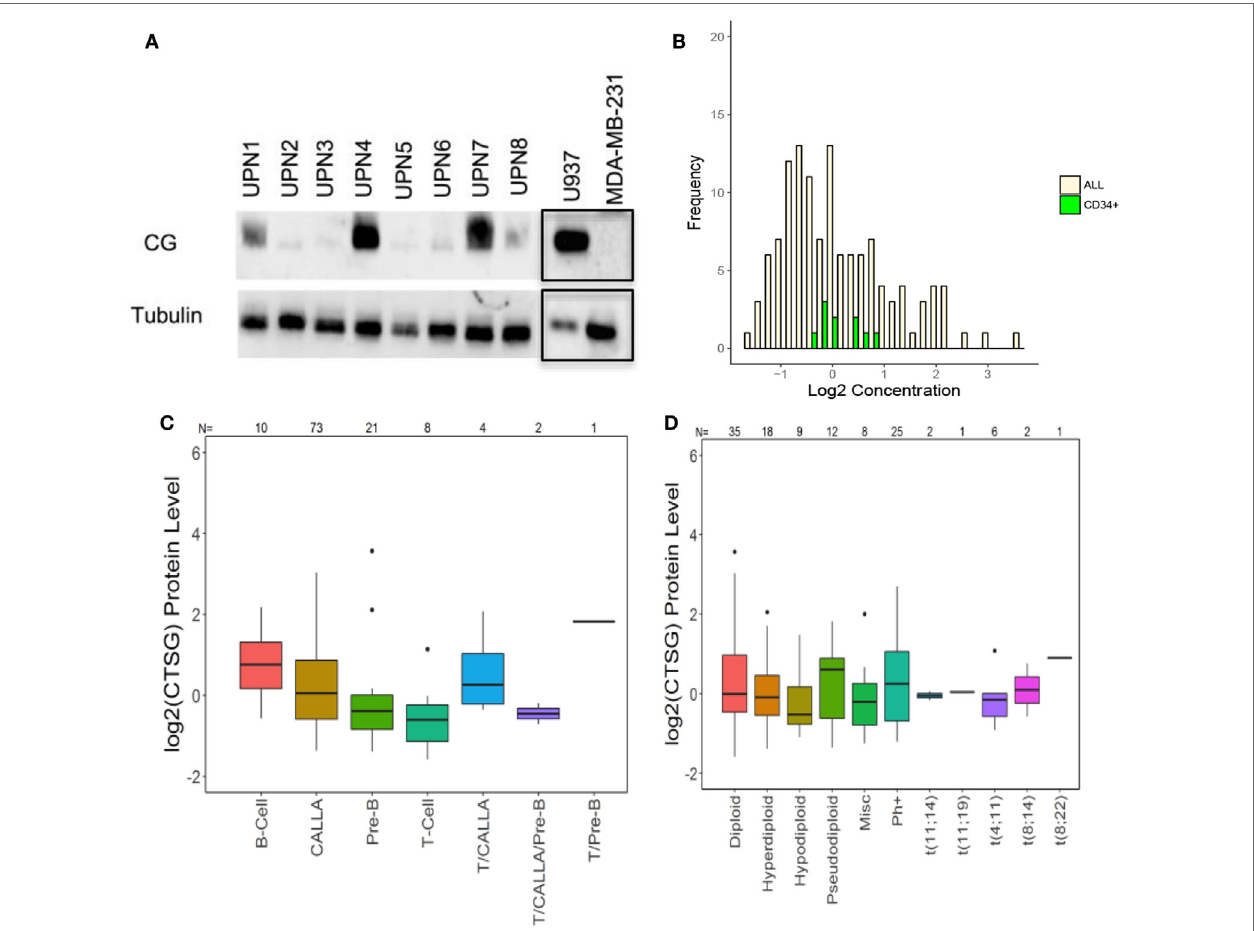
FigUre 2 | Cathepsin G (CG) is expressed at the protein level in B-ALL patient samples. (a) Western blots demonstrate CG protein in whole-cell lysates from eight different B-ALL patient samples ( Table 1 ). Gels were loaded with 30 µg of protein. U937 and MDA-MB-231 cell lines were used as positive and negative controls, respectively. Tubulin was used as a loading control. The black boxes outlining the U937 and MDA-MB-231 bands indicate that they were transposed from a different gel that was run in parallel. (B) Reverse-phase protein array was used to quantify protein levels of CG in blasts from 130 newly diagnosed ALL patients (yellow bars). Controls included healthy donor CD34 + progenitor cells (green bars). (c) Box plots show the levels of CG expression in ALL subtypes according to the French– American–British classification. (D) The relationship of CG protein levels is demonstrated with both normal and aberrant cytogenetic subgroups across 130 patient samples. Abbreviations: Misc,